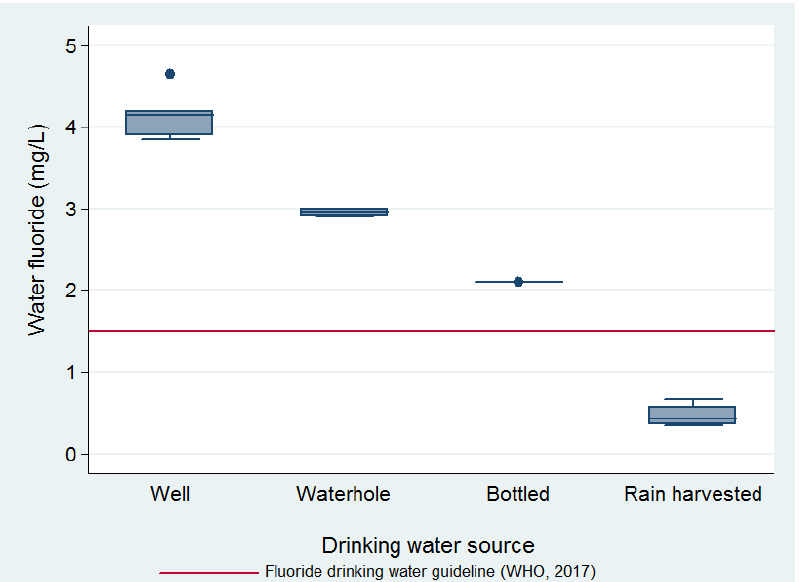
Figure 2. Water fluoride mean concentrations by drinking water source and in relation to the World Health Organization’s (WHO) drinking water guideline.